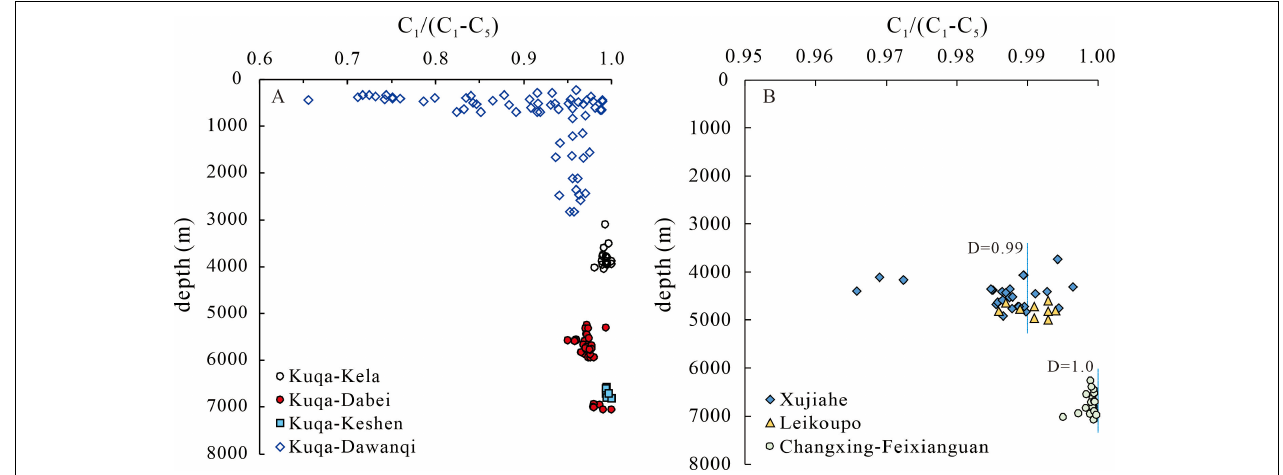
FIGURE 11 | (A) Plot of C 1 /(C 1 -C 5 ) vs. burial depth of natural gases from the Dabei, Keshen, Kela2 and Dawanqi gas fields in the Kuqa Depression, Tarim Basin. (B) Plot of C 1 /(C 1 -C 5 ) vs. burial depth of natural gases from the Xujiahe, Leikoupo and Changxing-Feixianguan formations of Yuanba gas field in Sichuan Basin. Data of Kela2 gas field were from Qin et al. (2007), data of Dawanqi oil field were from Zhou and Bao (2011) and Wang et al. (2012), data of Yuanba gas field were from Dai et al. (2013), Yin et al. (2013), Huang (2014), Wu et al. (2015b) and Li et al. (2016).